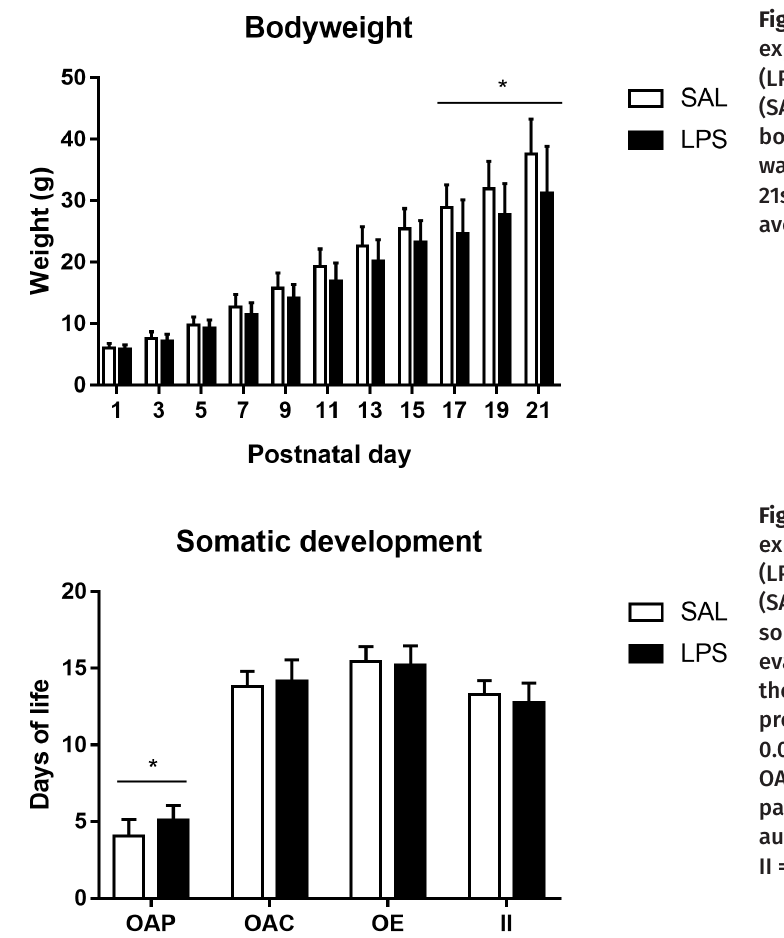
Figure 5. Effects of prenatal exposure to lipopolysaccharide (LPS), compared to the control group (SAL), on the development of rats: body weight (n=120). The evaluation was performed from the 1st to the 21st day of life. Data presented on average ± S.D. *p <